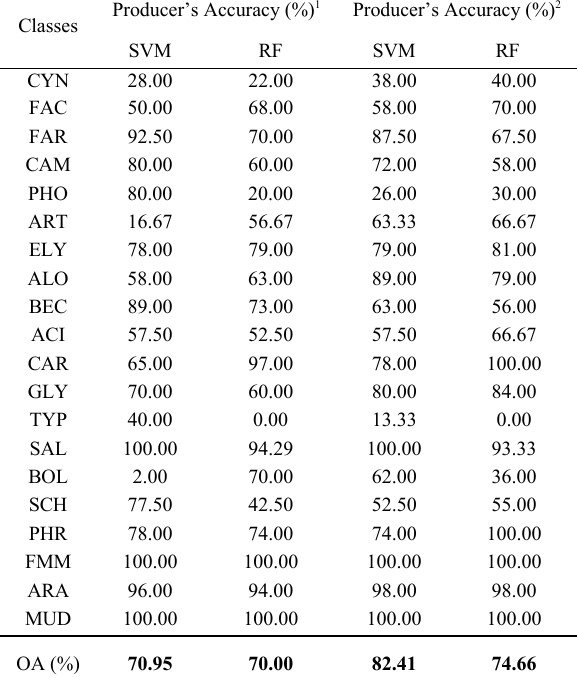
Table 2. Classification accuracies in respect to the SVM and RF classifiers using original bands (128) and random training samples, (1) 10 and (2) 30 pixels.